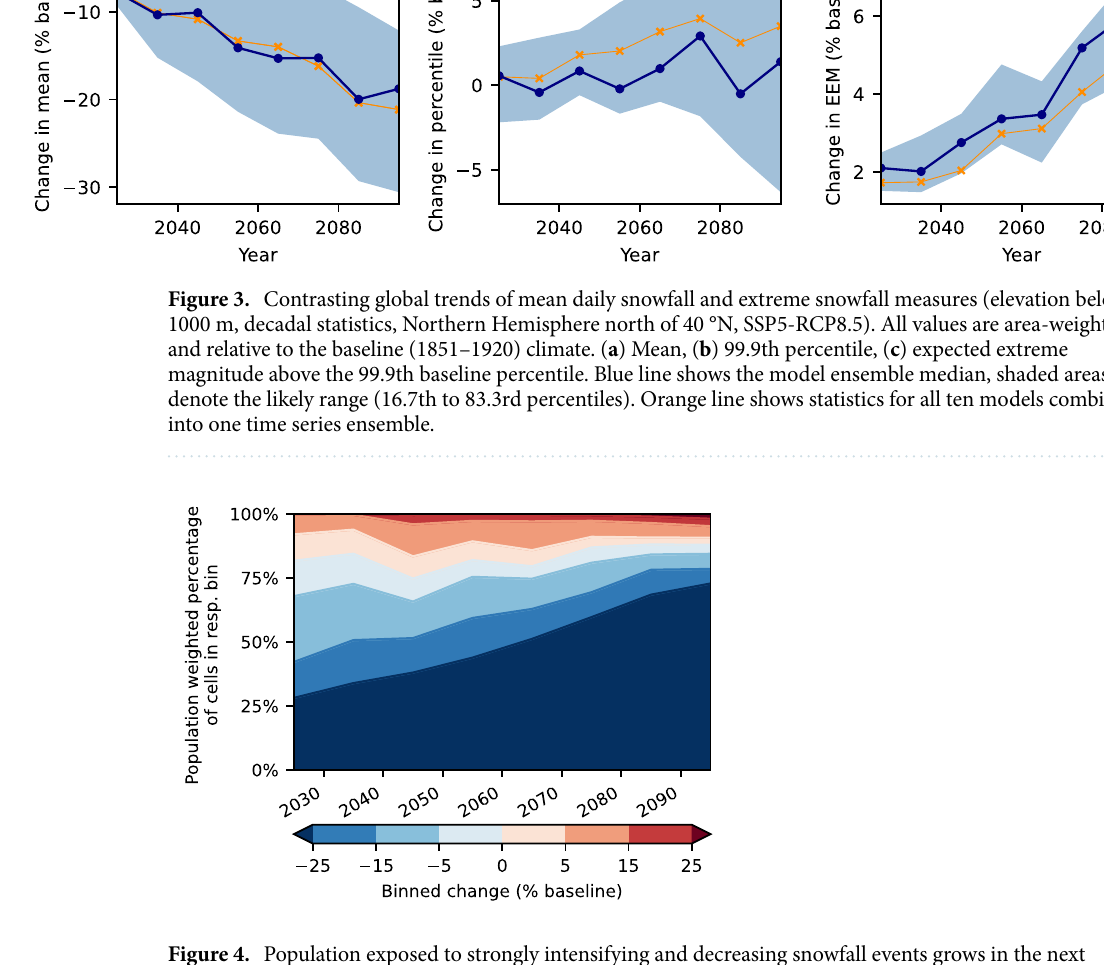
Figure 4. Population exposed to strongly intensifying and decreasing snowfall events grows in the next decades before a majority of population is experiencing decreasing extreme events at the end of the century. Global population weighted trend of 99.9th percentile (elevation below 1000 m, decadal statistics, Northern Hemisphere north of 40 °N, SSP5-RCP8.5). Binned according to change relative to the baseline (1851–1920) climate. Coloured area represents the population weighted percentage of cells in the respective bin. Population is fixed to a 2020